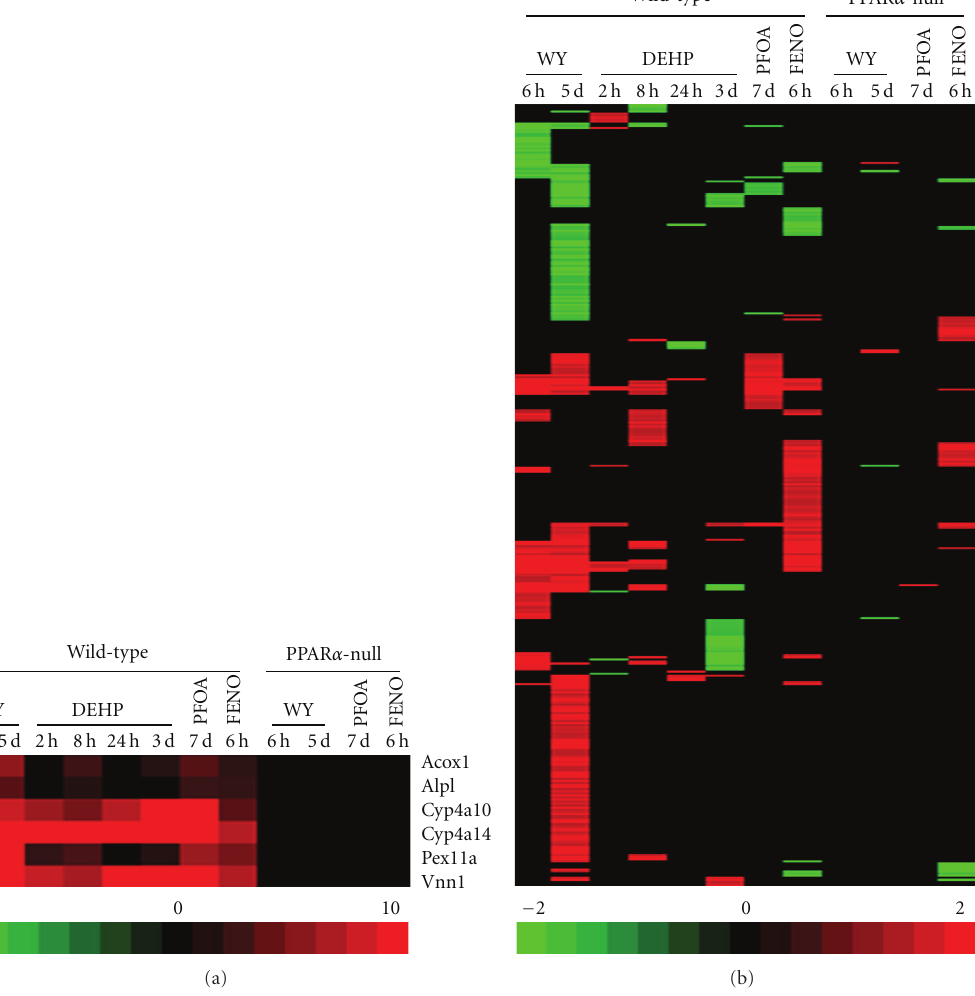
Figure 2: Altered expression of proteome maintenance genes by diverse PPC is predominantly PPAR α dependent. Wild-type or PPAR α - null mice were treated with WY, DEHP, PFOA, or FENO for the indicated times. Hepatic mRNA transcripts were assessed using full- genome A ff ymetrix arrays. Genes involved in PM including protein chaperones were identified as described in Section 2. (a) Positive control genes. (b) Expression of all PM genes altered by at least one of the treatments. Genes were clustered using one-dimensional hierarchical clustering. All genes are found in Supplemental Material. Red: up-regulation; green: down-regulation; black: no change. The intensity scales indicate fold-change due to chemical exposure relative to controls. Abbreviations: WY: WY-14,643; DEHP: di-(2-ethylhexyl)phthalate; PFOA: perfluorooctanoic acid; FENO: